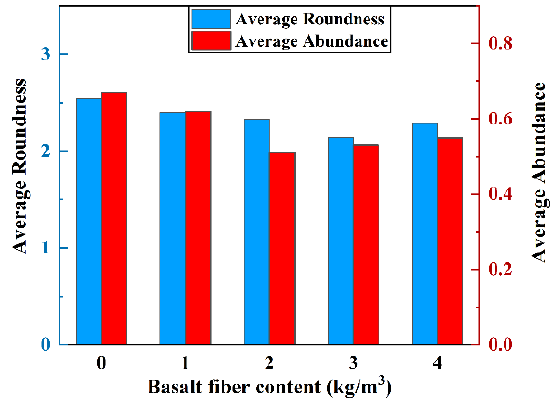
Figure 13. Particle microparameters.